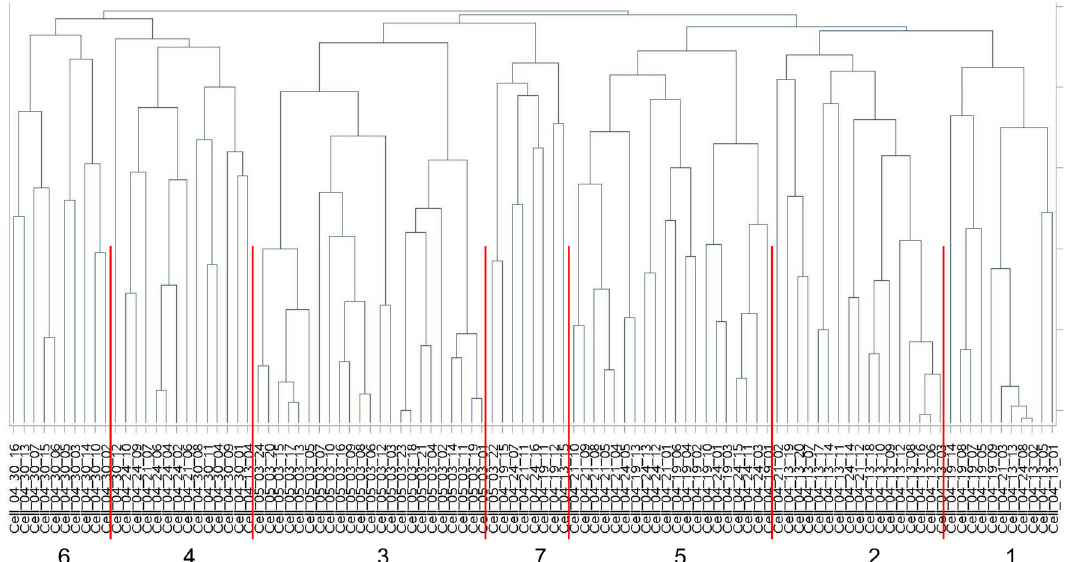
Figure 4. Clustering analysis of female AM. A clustering analysis of the female AM (n = 103 cells) was performed using SAS, Version 9.4 and the resulting dendrogram is shown. The clusters have been delineated with the red lines and are numbered. Cluster numbers are assigned by the statistical